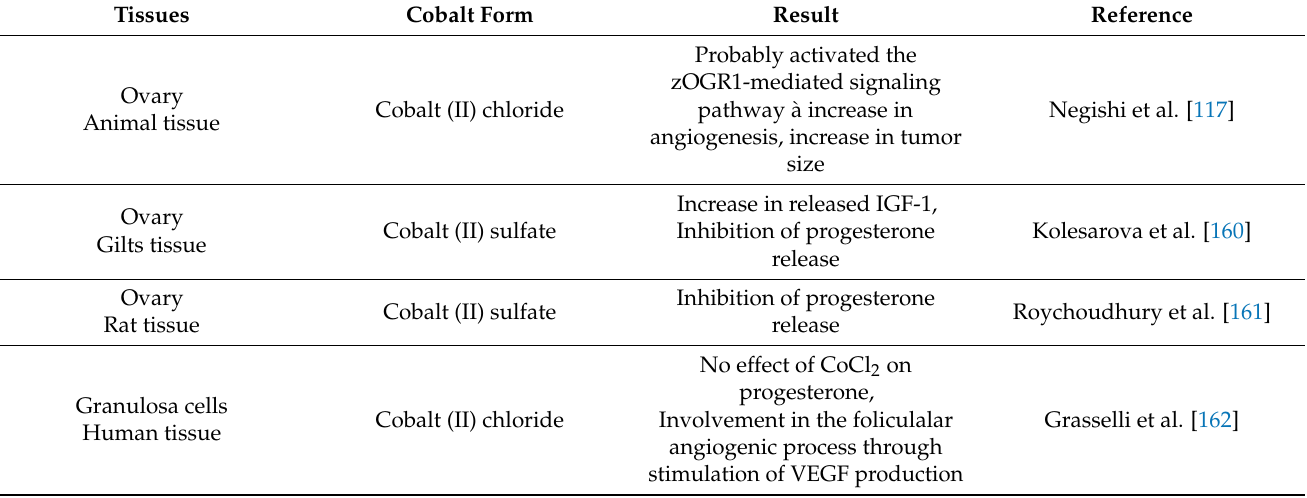
Table 1. Effects of cobalt and its compounds on specific tissues.